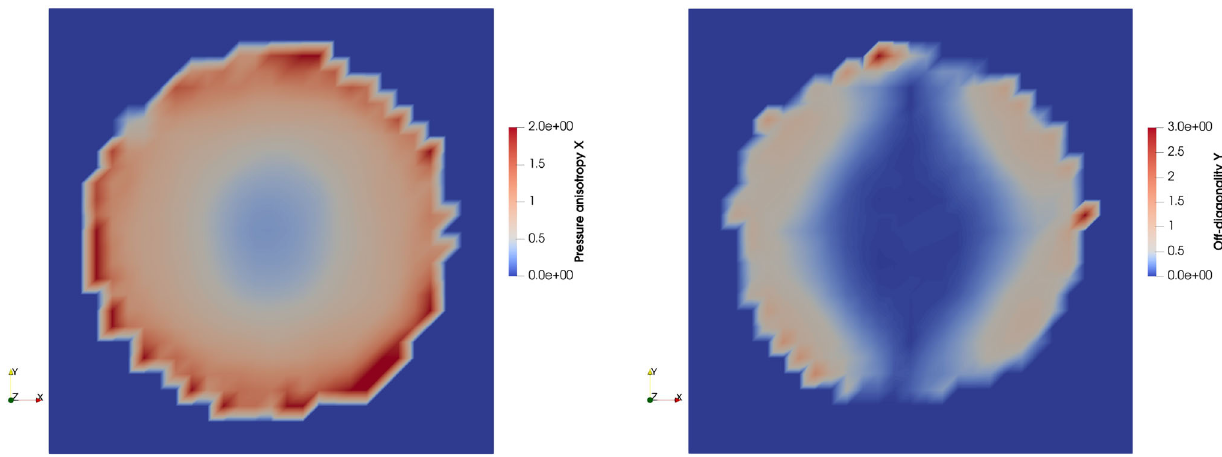
Fig. 25 Au+Au collisions at E lab = 1.23 AGeV, 0–5% centrality class, 1080 events, t = 10 fm, z = 0. Average energy momentum tensor evaluated taking into account both participant and spectator hadrons. Left: Pressure anisotropy X, right: off-diagonality Y